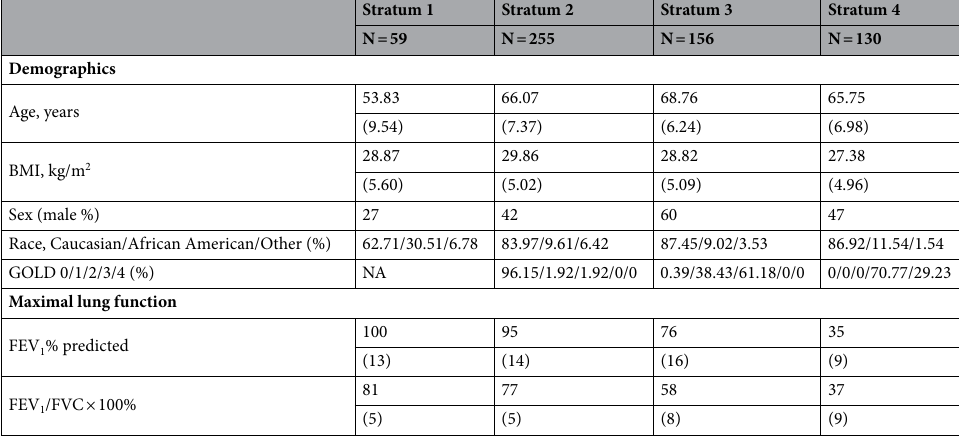
Table 1. Demographic data and PFT measures for COPD patients in each stratum. Entries are mean (SD) unless otherwise